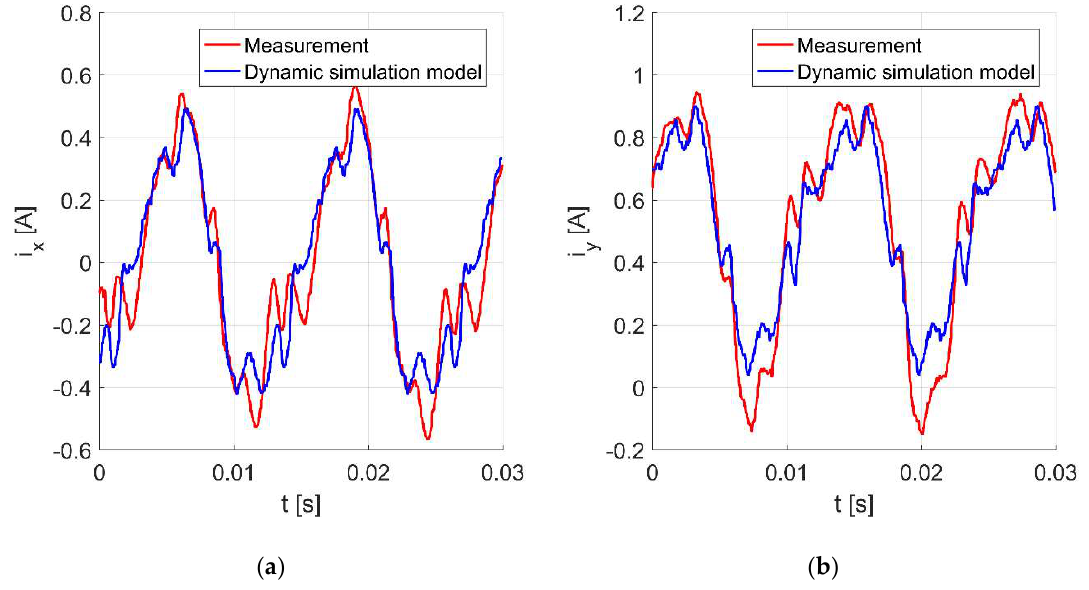
Figure 13. Time responses of the control currents i x ( a ) and i y ( b ) for the rotor rotation with 4724 rev/min.